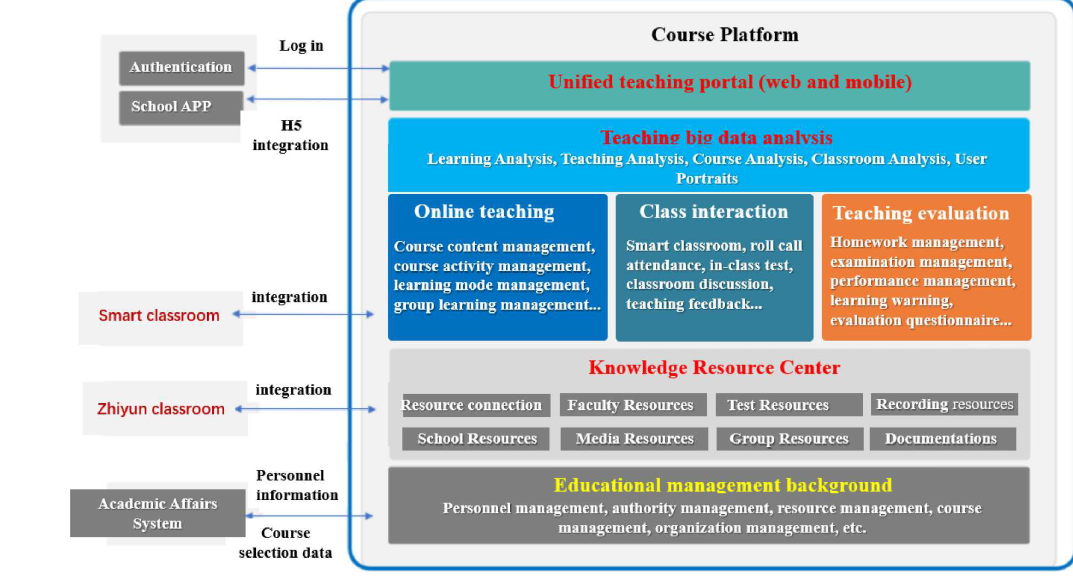
Fig. 4 The information flow of the course